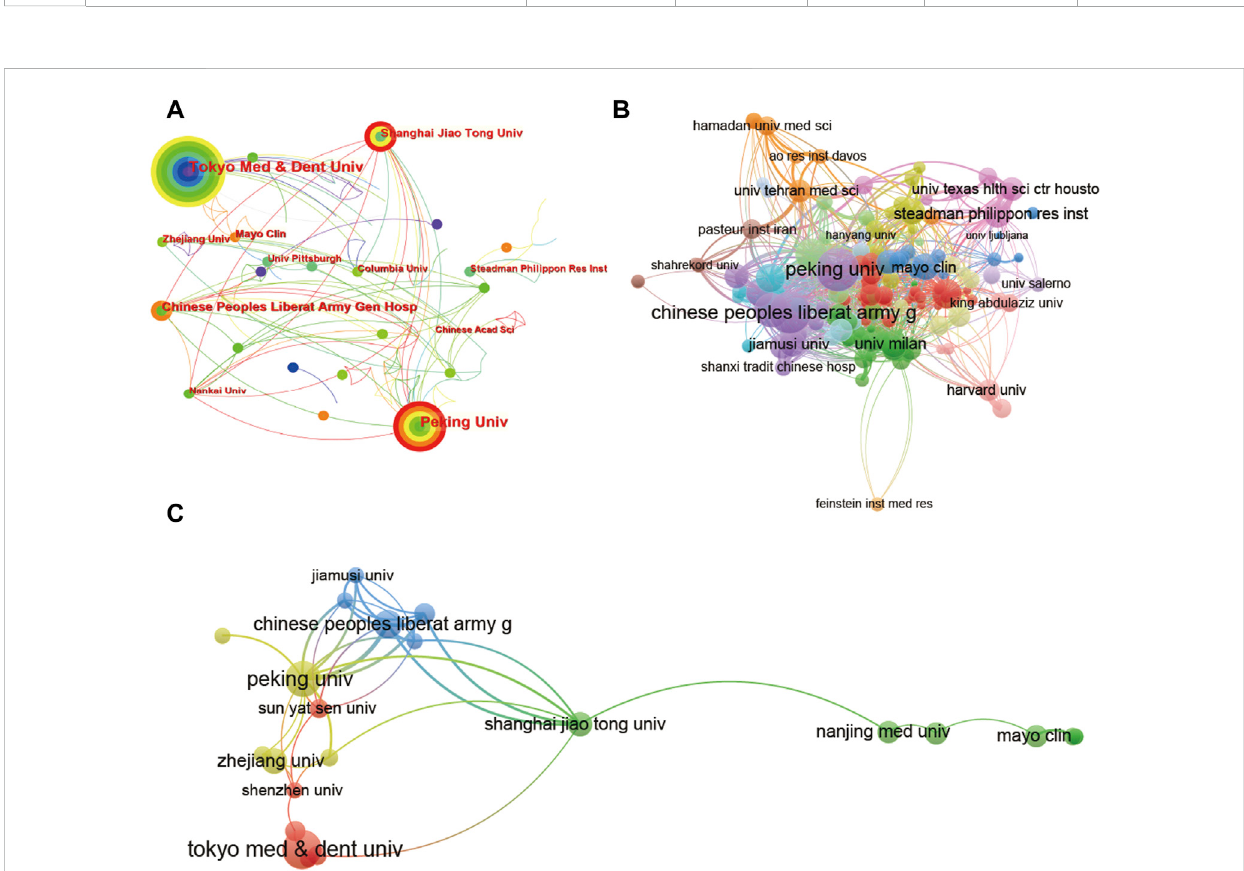
FIGURE 5 Mapping of institutions associated with stem cells for meniscal regeneration. Institutional collaboration analysis based on CiteSpace (A) and Vosviewer (B) . (C) The authorship-institution collaboration analysis via Vosviewer. The nodes represent countries/regions or institutions, and the lines connect them. The number of publications grows proportionally to the size of the nodes. The lines between the nodes represent the cooperation relationship, and the thickness of the connecting lines represents the strength of their cooperation; the closer the cooperation is, the thicker the connecting lines. The nodes with the outermost red circles have higher